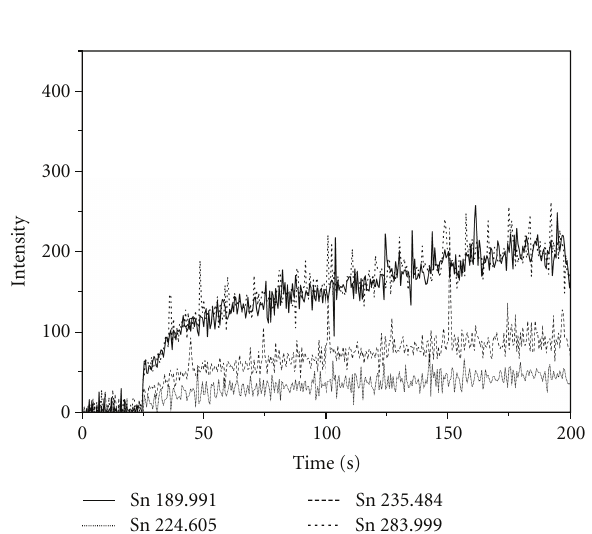
Figure 2: Time resolved analysis (TRA) of Sn solution (1mg L − 1 in tartaric acid) by